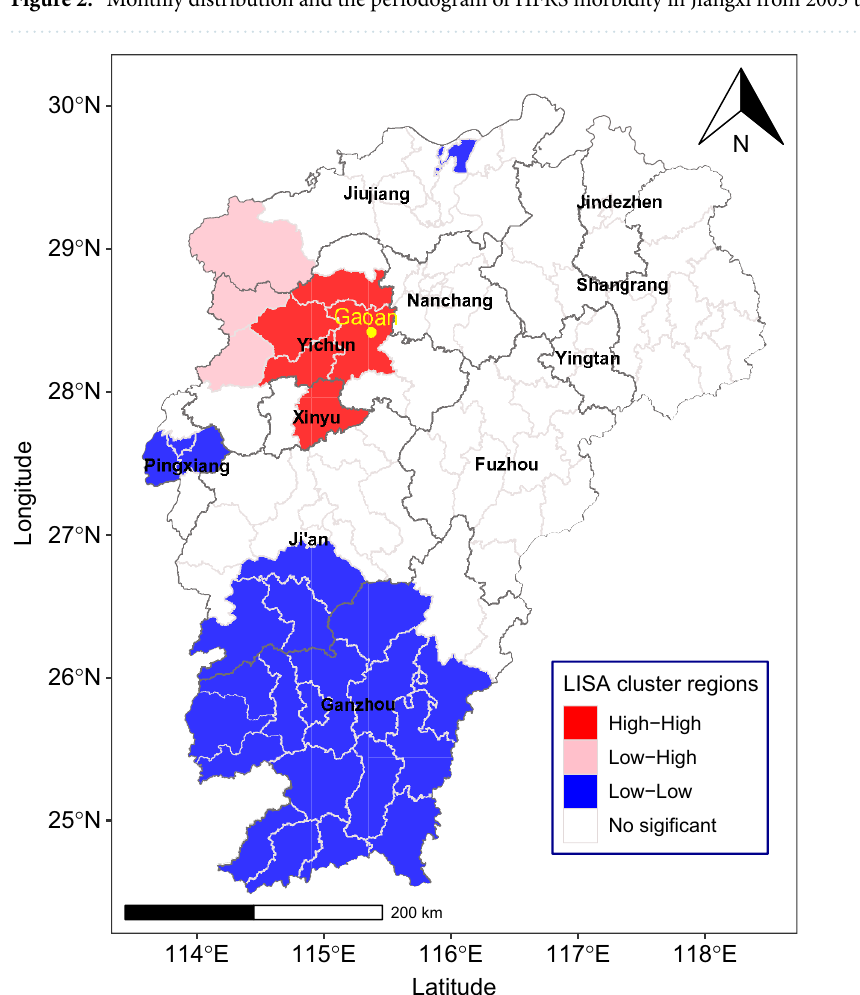
Figure 3. The local indicators of spatial association (LISA) cluster map of HFRS morbidity in Jiangxi Province from 2005 to 2021. The map was generated by ArcGIS software (Version 10.4 ESRI, Redlands, CA, USA, https:// www. esri. com/ sofwa re/ arcgis/ arcgis- for- deskt